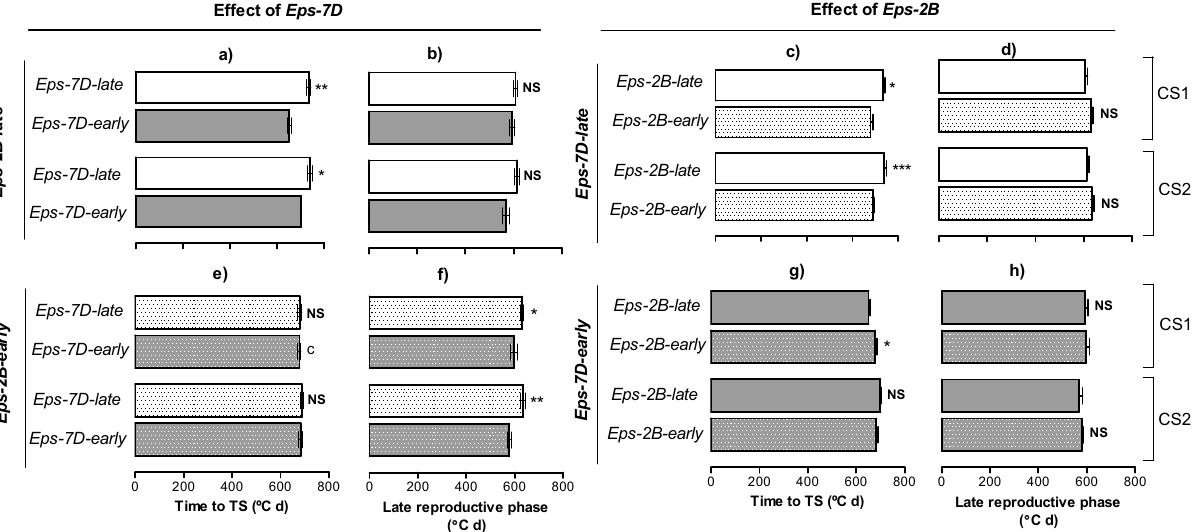
Figure 2. Duration of the two pre-anthesis phases considered: time from sowing to terminal spikelet (TS) and from then to anthesis, the late reproductive phase as affected by Eps-7D (left panels) and Eps-2B genes (right panels) on backgrounds contrasting in the allelic form of the other Eps gene (top and bottom panels for the late and early alleles of the other Eps gene). Data are shown for each of the two cropping seasons (CS1 and CS2). Segments in each bar stand for the SEM. Significance level shown for the differences between alleles within each season: *p < 0.05; **p < 0.01; NS non-significant.